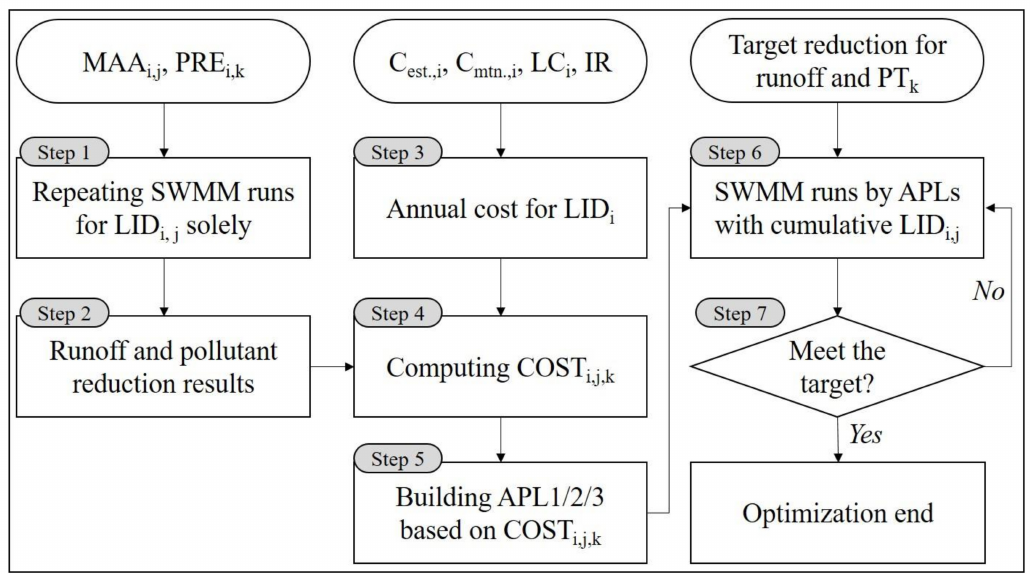
Figure 2. Schematic flow of low impact development (LID) optimization based on annual